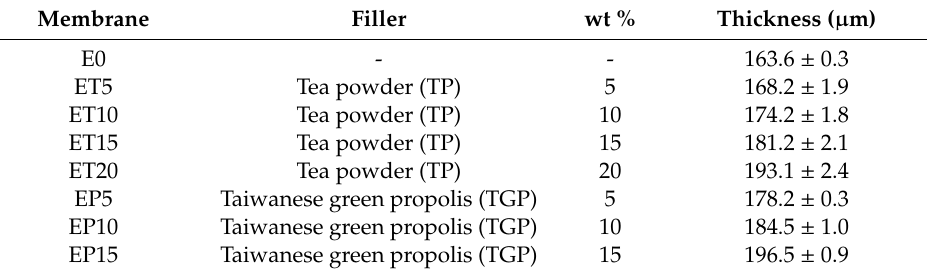
Table 1. Filler content of the obtained acrylic